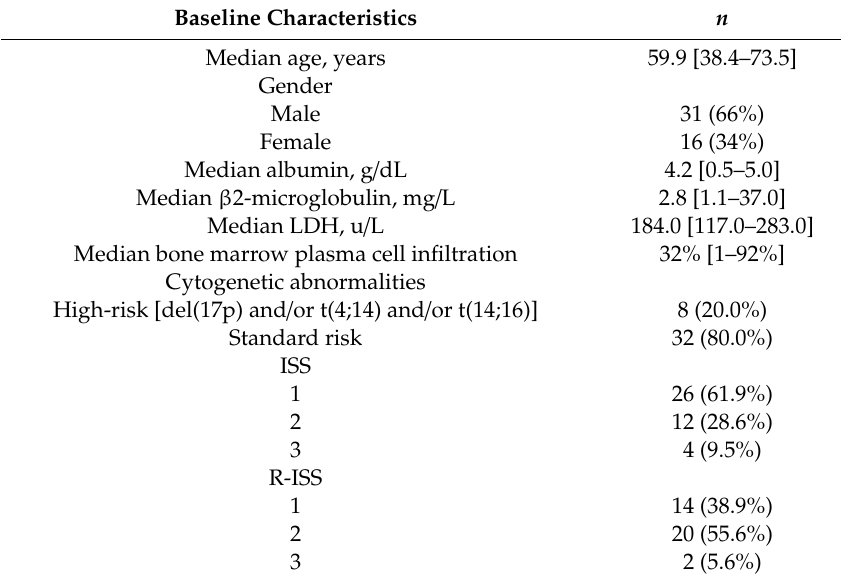
Table 1. Baseline patient